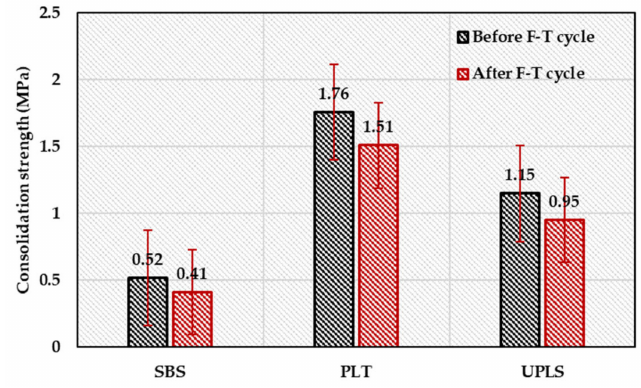
Figure 18. Consolidation strengths of the three waterproof coatings after F–T